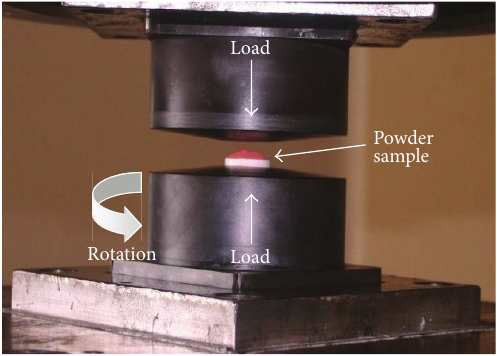
Figure 1: Picture of HPT apparatus and